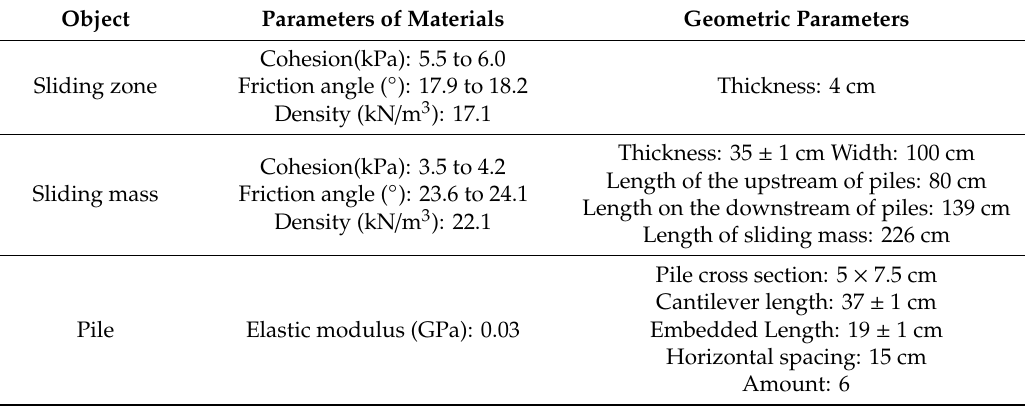
Table 1. Main features of the landslide stabilizing piles